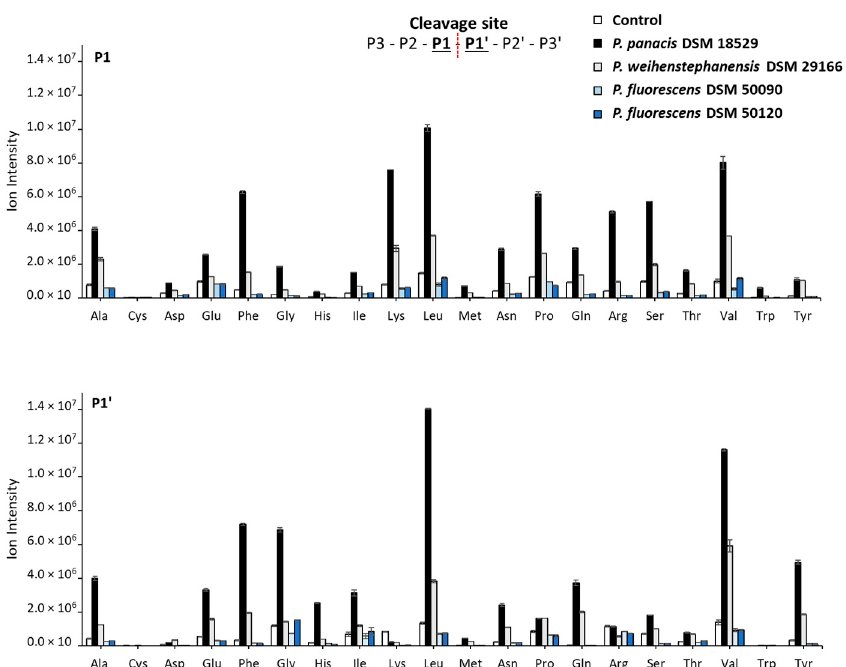
Figure 4. Total ion intensities of peptides distributed according to their P1 and P1 ′ cleavage sites per strain used to obtain the extracellular extract and control after 45 days of skimmed UHT milk storage based on extracted peptides subjected to nanoLC timsTOF Pro MS/MS peptidomics.